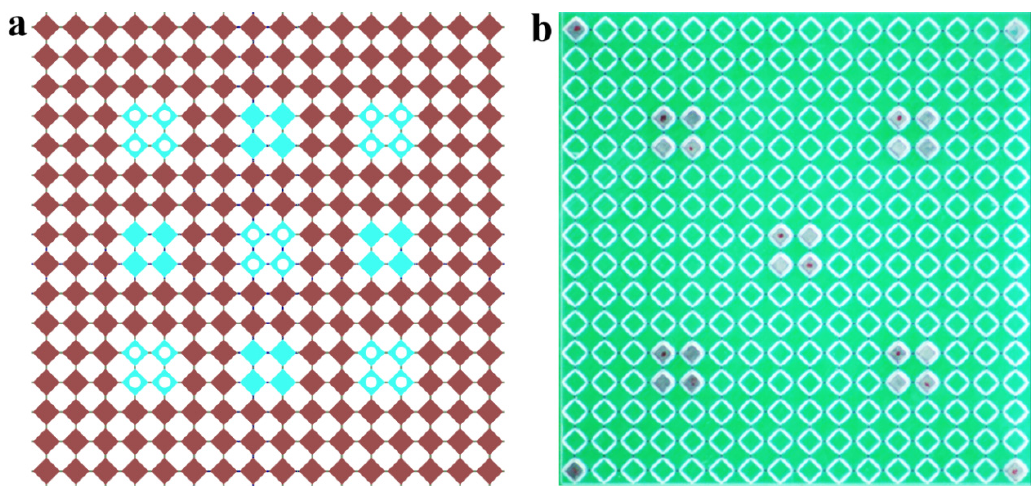
Figure 5. Arrangements of the magnets in 16 × 16 metamaterial used for experiments and simulations. (a) Blue squares mark the positions of the magnets for the arrangement I, white circles mark the positions for the arrangement II. (b) Example of 3D printed metamaterial with embedded magnets (arrangement II). Four magnets in the corners are used for the mounting in the fixtures and do not affect the behavior of the metamaterial during tests. Materials 2020 , 13 , x FOR PEER REVIEW